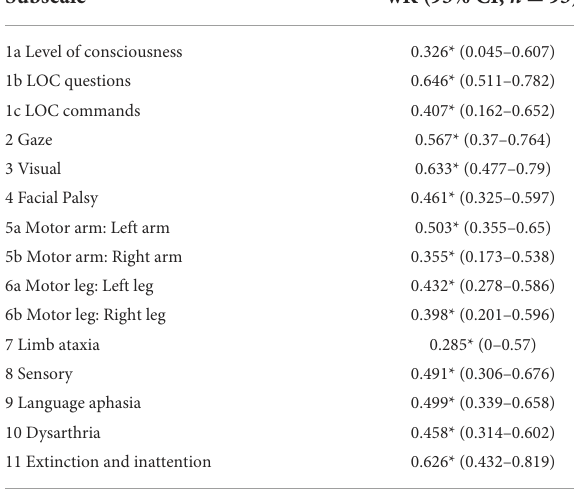
disagreement within two NIHSS points. The results indicate excellent reliability (ICC = 0.939).